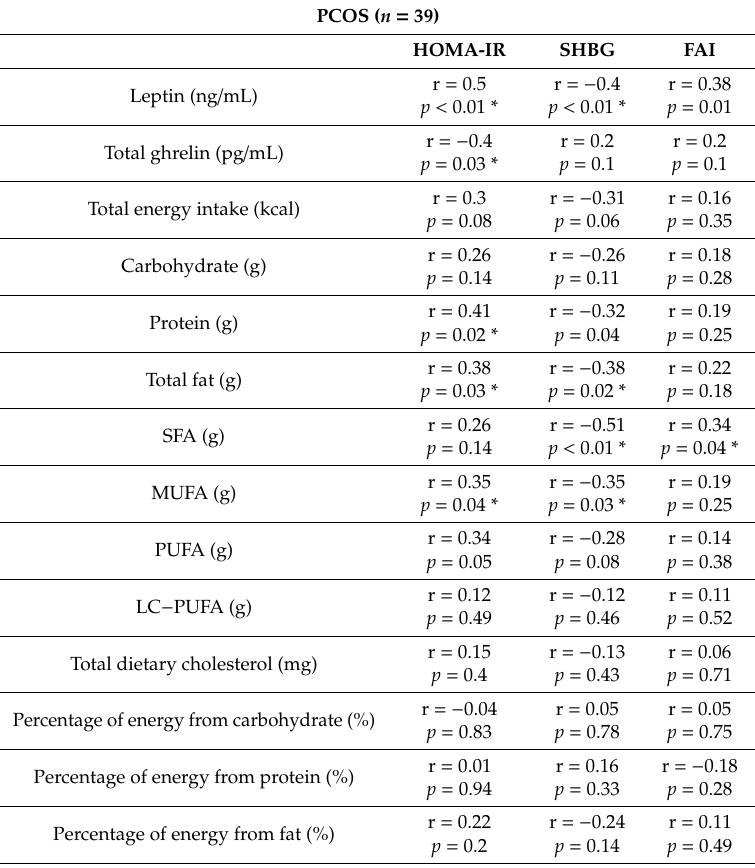
Table 4. Correlations between hormones, HOMA-IR, and the dietary intake of macronutrients in polycystic ovary syndrome (PCOS)